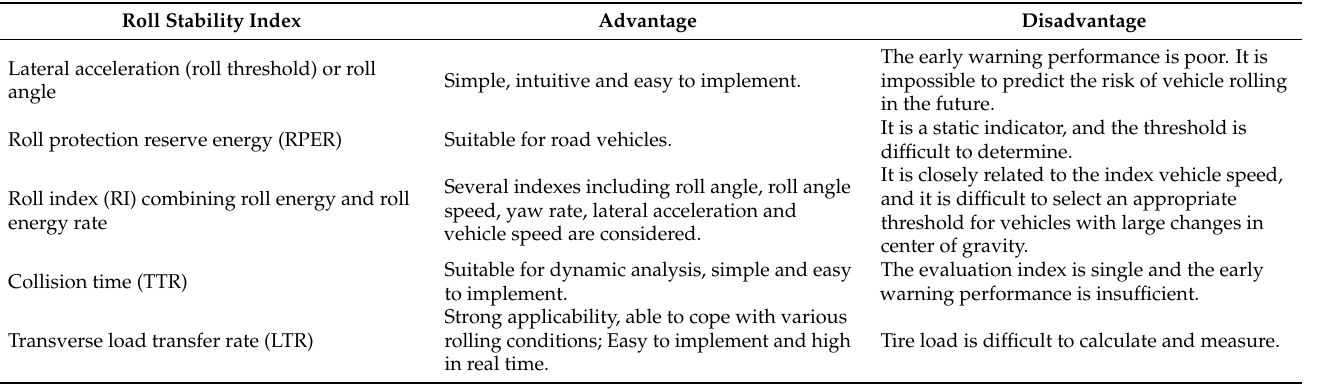
Table 2. Common vehicle roll stability indicators and their advantages and